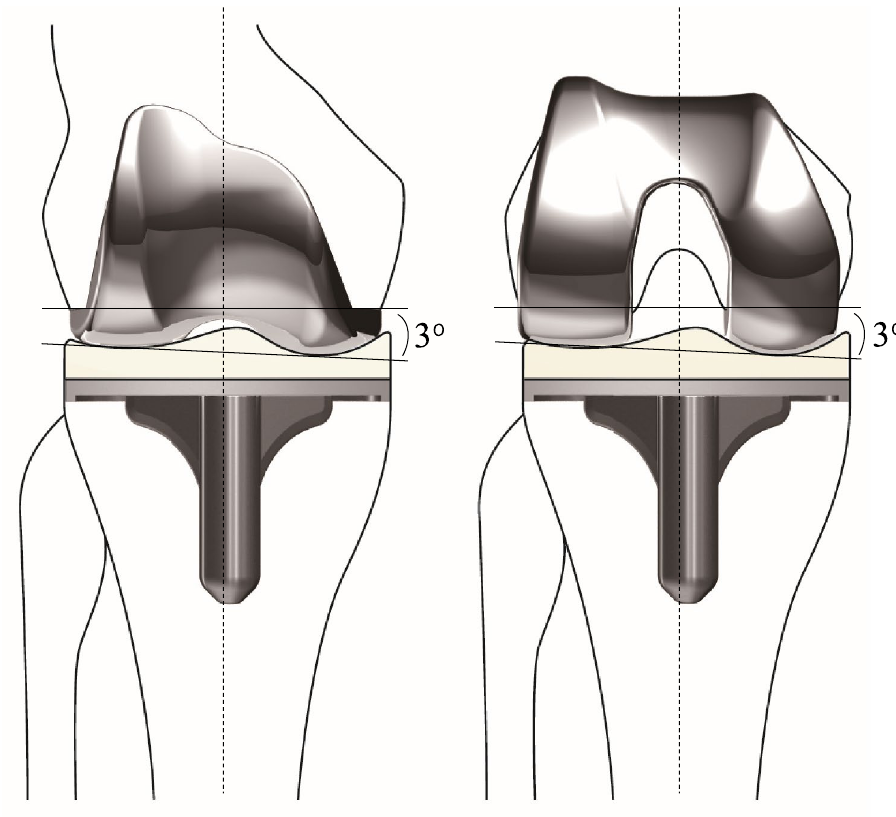
Figure 1. The FINE total knee. The femoral condyle has an asymmetric shape and femorotibial joint line with an inclination of 3° both in coronal (left) and axial (right) planes. The medial and lateral condyle have different length of radii (medial larger than lateral), resulting in medially inclined joint line both in extension and flexion. The medial surface of the polyethylene insert has a convex curve while the lateral surface has a flat surface. The figure is reprinted with minor modifications from Fig. 1 in reference